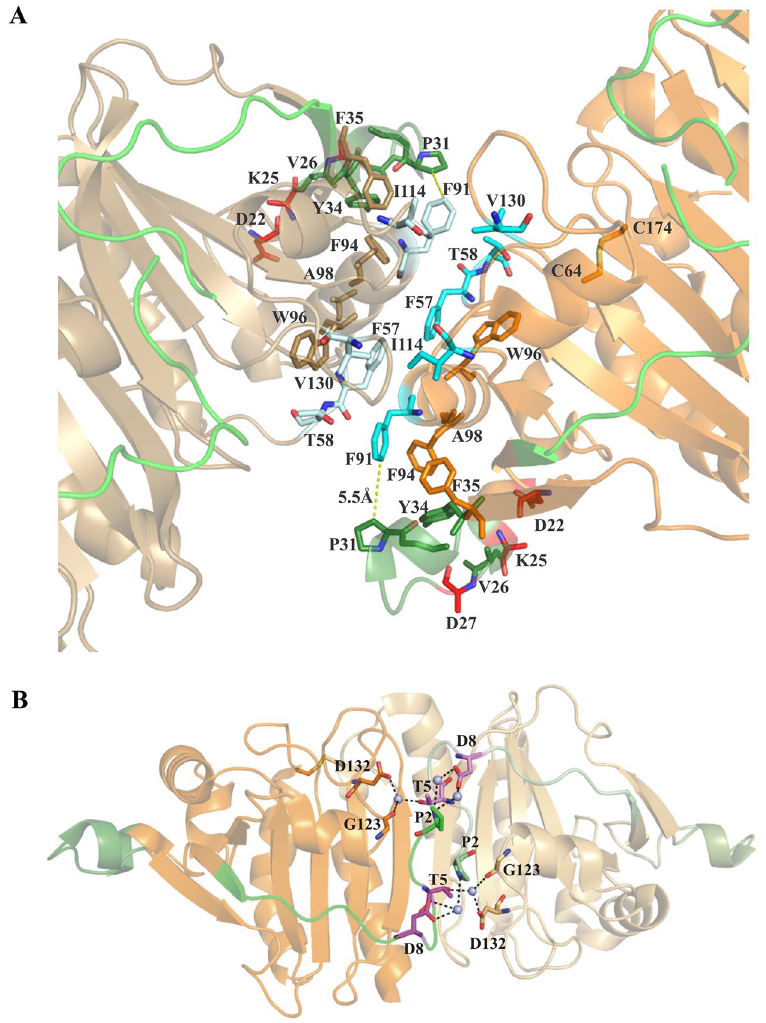
Figure 9. ( A ) Dimer-dimer interface of the Mt AhpC C176S structure (PDB ID: 2BMX) 13 . The first monomer is shown in orange and the second monomer is shown in sand color. The N-terminal 1–15 residues are shown in green and the extra loop (23–34) in the N-terminal is shown in forest green . The hydrophobic residues F57, T58, F91, I114 and V130 that stabilize the interface are shown in cyan . The mutants D22, K25 and D27 are highlighted in red . ( B ) Critical residues in the dimer interface of mycobacterial AhpC (PDB ID: 2BMX) 13 . The mutant residues T5 and D8 are shown in magenta . The subunits are shown in orange with the second in lighter shade. The N-terminal 1–15 residues are shown in green and the extra loop (23–34) in the N-terminal is shown in forest green . The water molecules involved in the water mediated interaction are shown as light blue